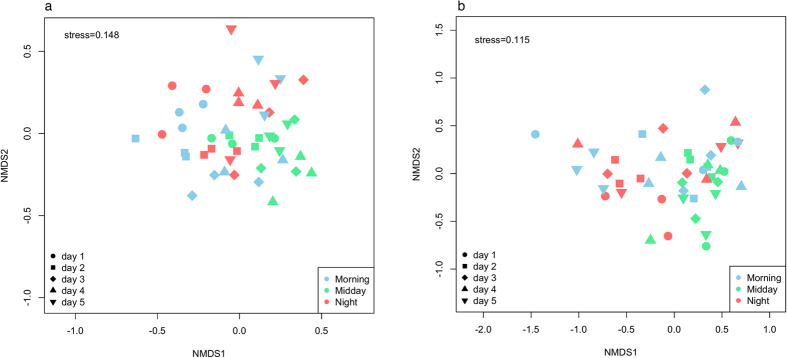
Non-metric multidimensional scaling (nMDS) ordination of Bray–Curtis distances between microbial communities (cDNA-based) inferred from (a) T-RFLP community fingerprinting and (b) 454-pyrosequencing. Each point represents a bacterial community at a specific time-point (n = 45).